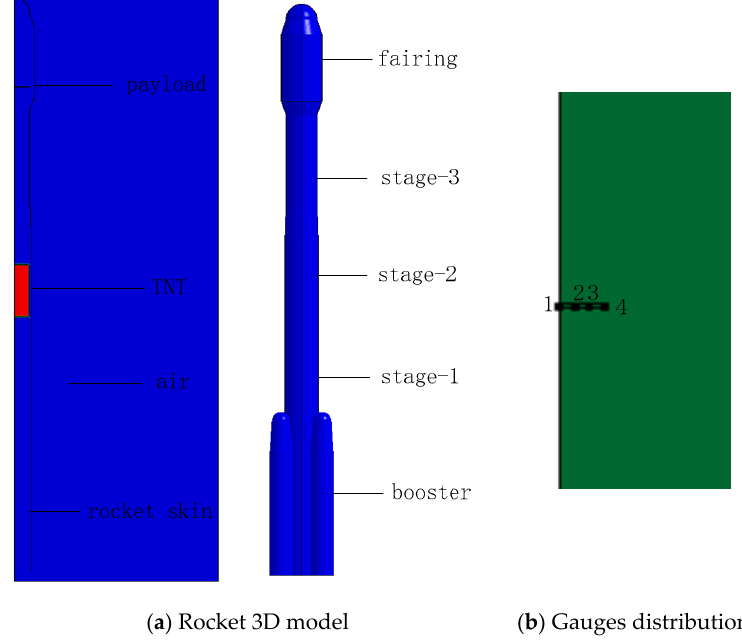
Figure 2. Rocket 3D finite element model and gauges distribution.